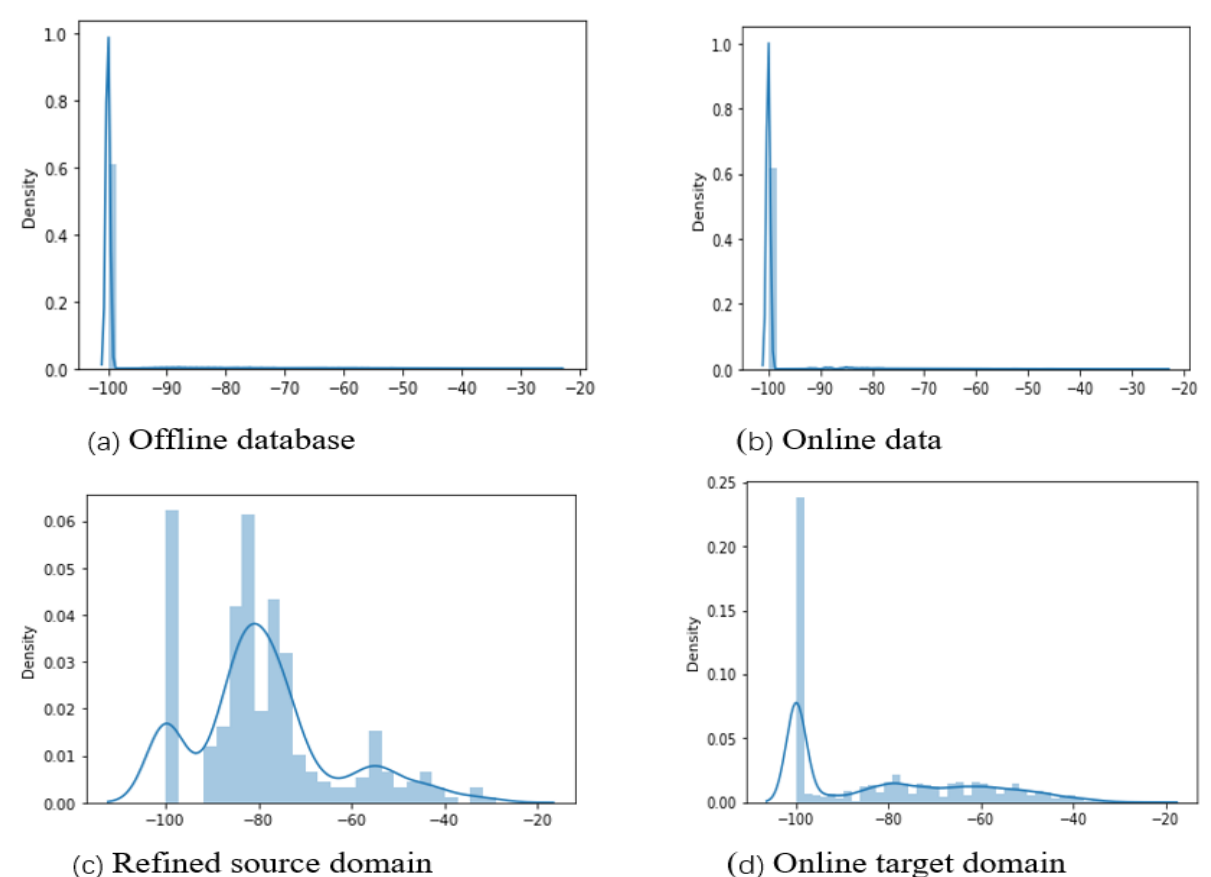
Figure 11. Distributions of RSS Wi-Fi APs of offline and online databases before and after transfor- mation.